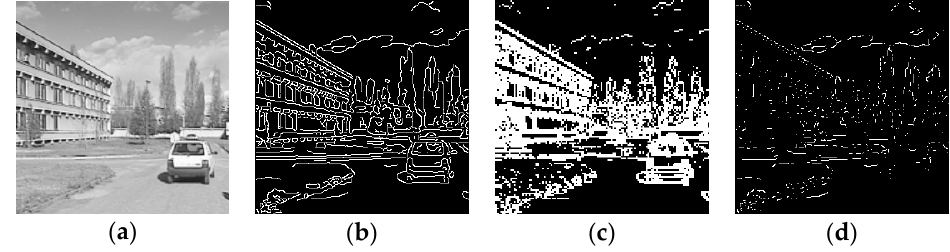
Figure 2. The differences in detection results by singular value decomposition (SVD) and edge detection: ( a ) the test image, Car1; ( b ) a binary image of the edge regions; ( c ) a binary image of the image’s SVD result; ( d ) the binary image of the image’s edge regions that were not detected by SVD.